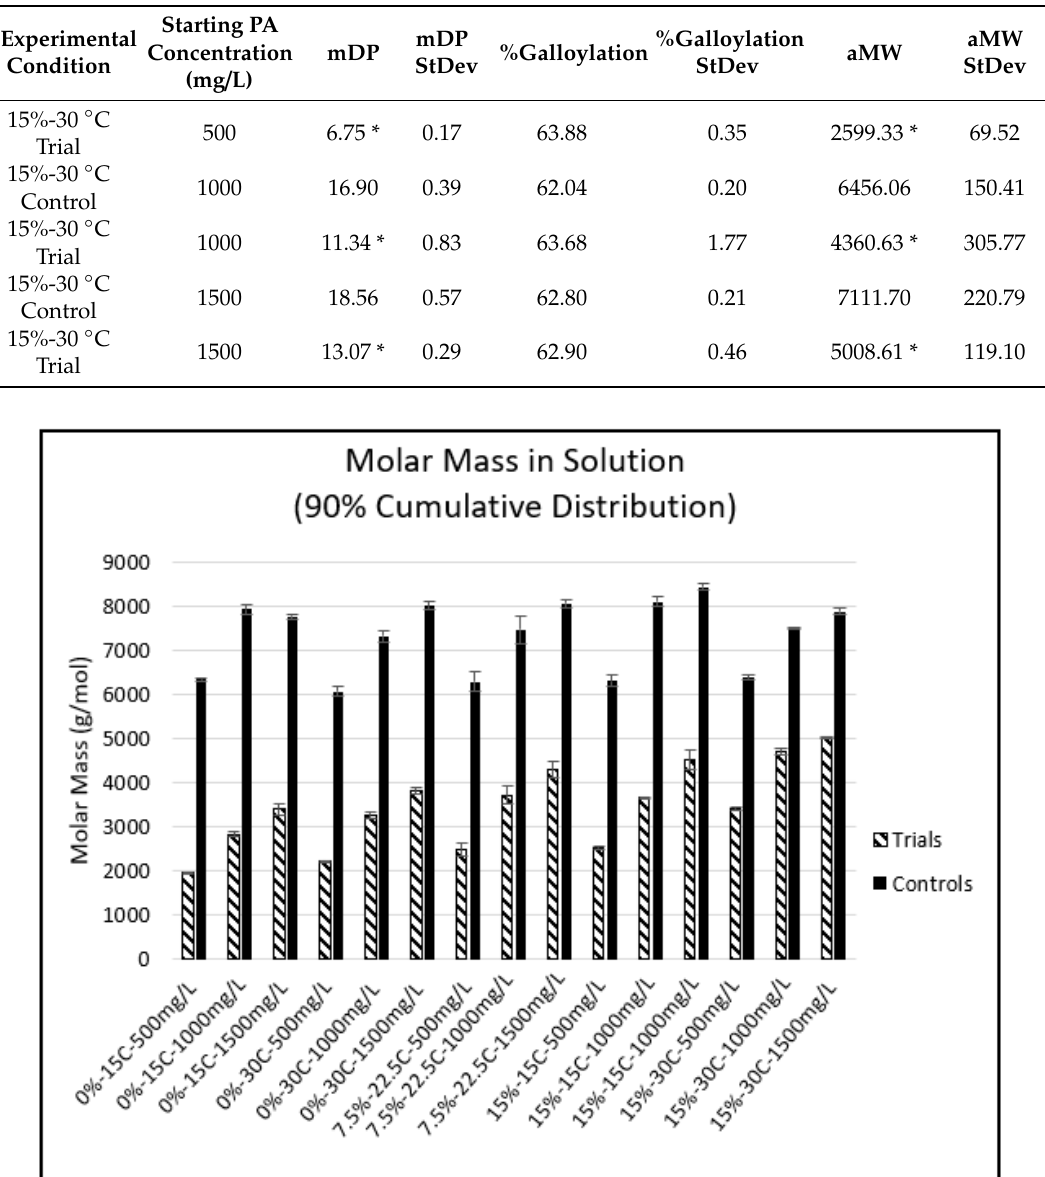
Figure A1. Molar mass distribution at 90% cumulative mass of control and trial samples from adsorption experiments ( n = 3). Table A2. Average mass PA adsorbed to cell wall material after system reached equilibrium in the presence of anthocyanins. Values are presented in mg PA (C.U.) per mg CWM ( n = 3). Respective standard deviations are displayed to the right of each data point. Values are represented in Figure 2.